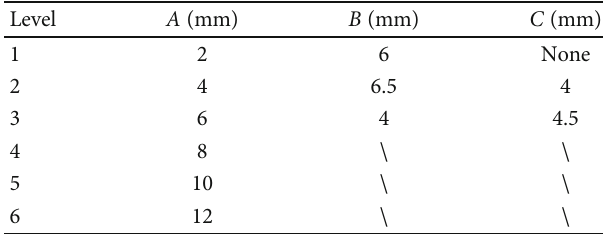
Figure 5: Schematic diagrams of the air-gap magnetic density waveform: (a) initial structure and waveform; (b) improved structure and expected waveform. Table 2: Motor optimization parameters and level